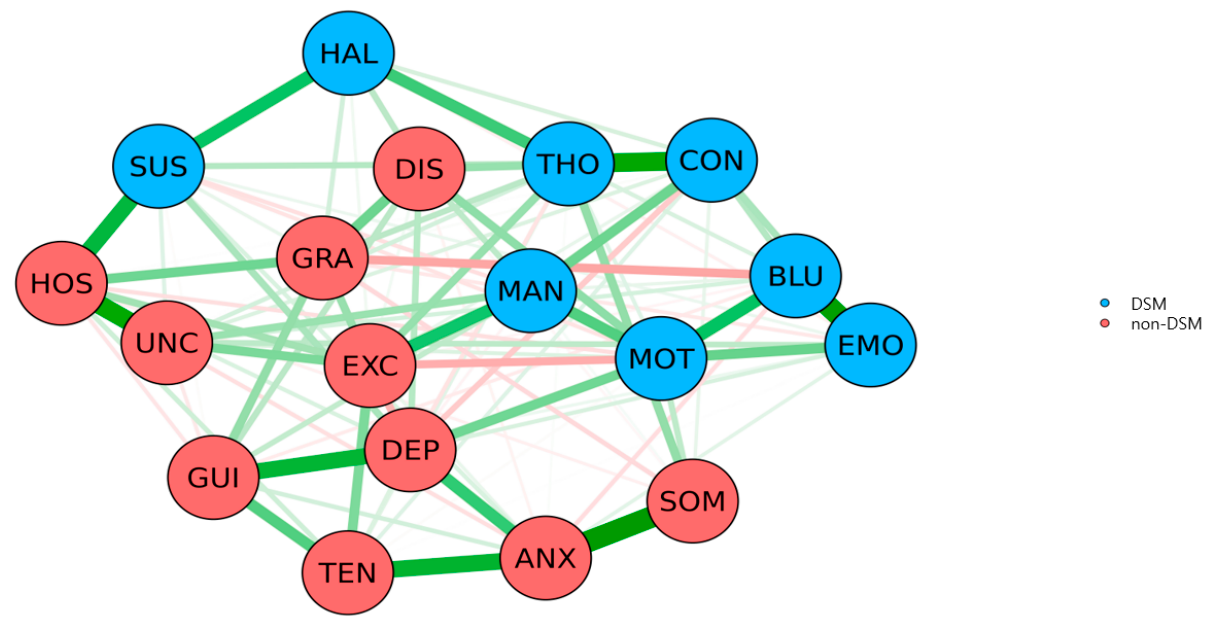
Figure 3. Comparison of node statistics of DSM symptoms and non-DSM symptoms within the network structure of BPRS items in Asian patients with schizophrenia ( n = 1438; Difference test p - value = 0.814). Green lines represent positive associations, whereas red lines represent negative associations between the connecting nodes. The thickness of the lines represents the strength of the edges. Abbreviations: ANX, anxiety; BLU, blunted affect; CON, conceptual disorganization; DEP, depressive mood; DIS, disorientation; EMO, emotional withdrawal; EXC, excitement; GRA, grandiosity; GUI, guilt feelings; HAL, hallucinatory behavior; HOS, hostility; MAN, mannerism and posturing; MOT, motor retardation; SOM, somatic concern; SUS, suspiciousness; THO, unusual thought content; UNC,